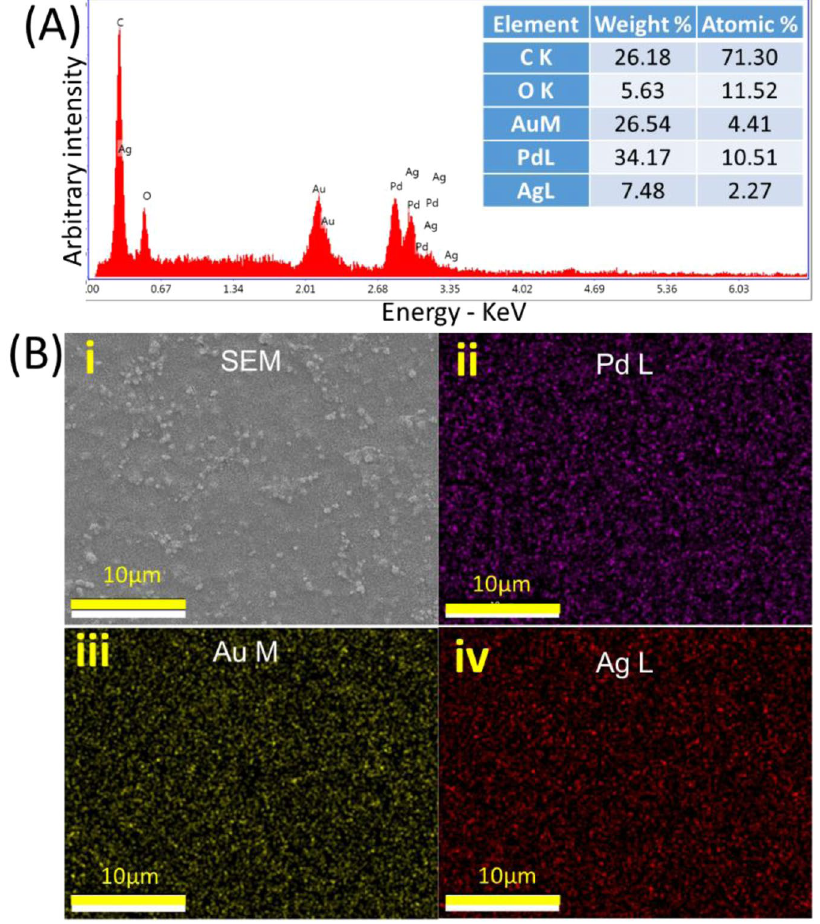
Figure 3. EDS characterization of the test strip. ( A ) EDS spectrum and ( B ) EDS mapping of the AgNP-coated commercial glucose test